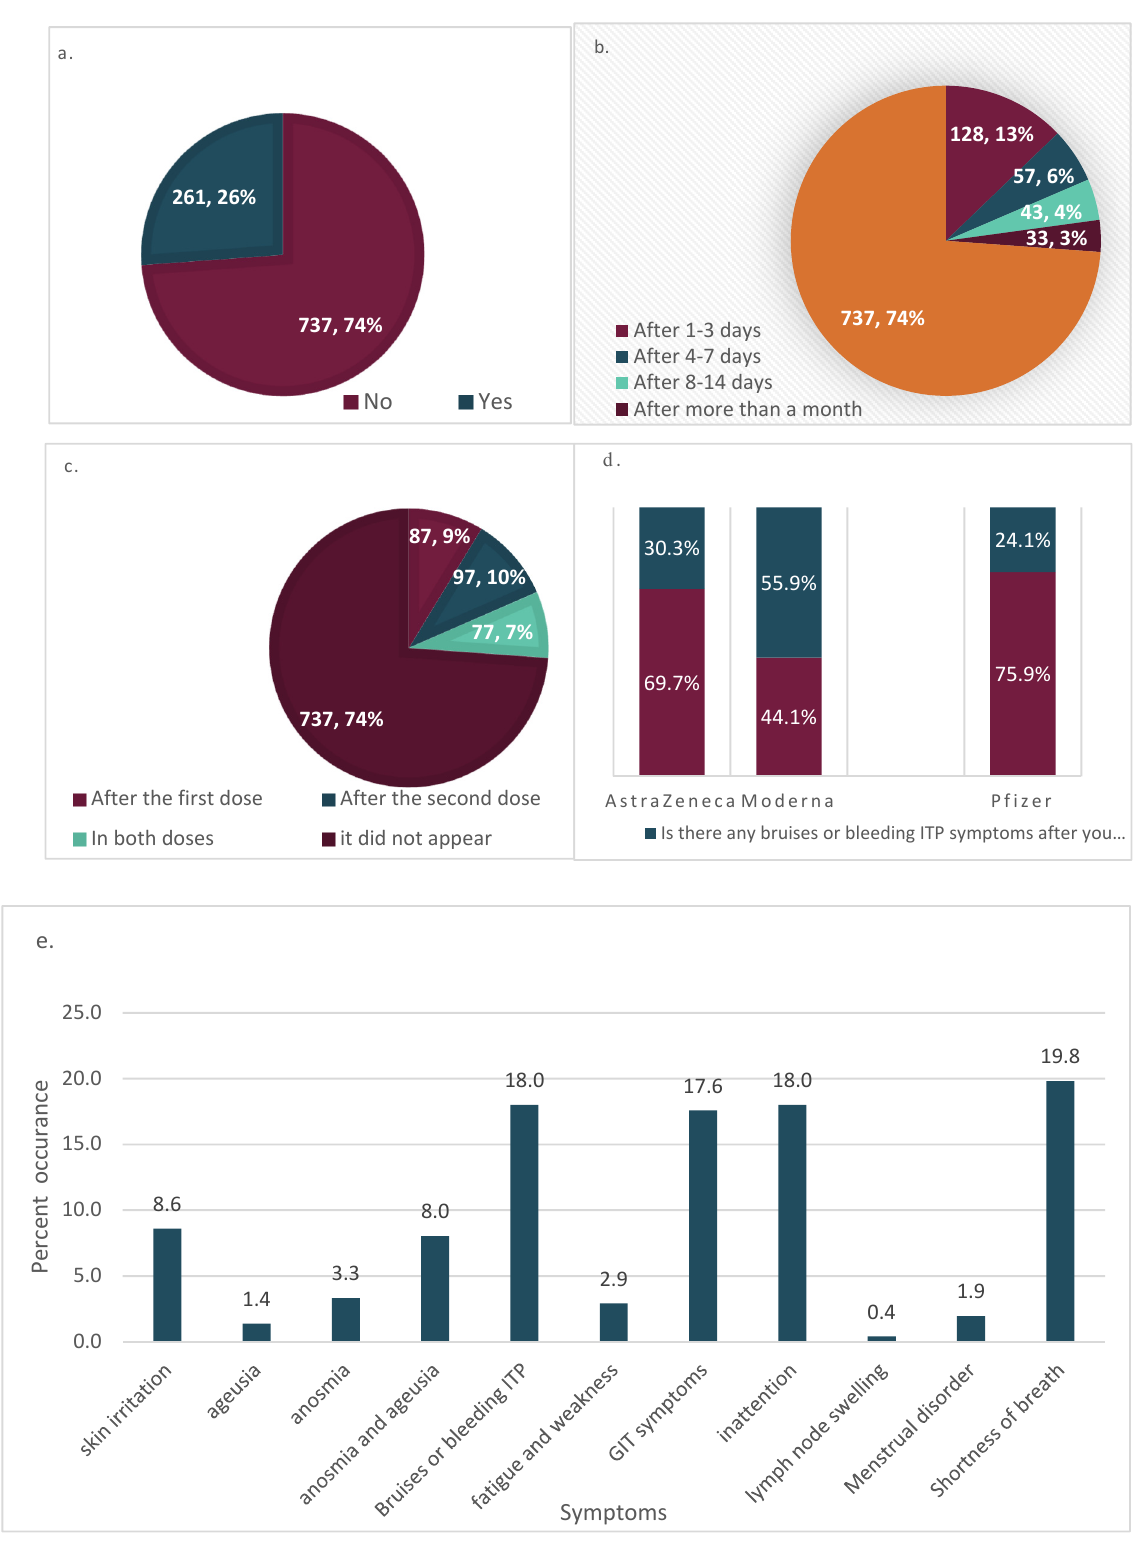
Figure 2. ( a ) Frequency of bruises or bleeding symptoms with high fever post any COVID vaccine administered in Saudi Arabia. ( b ) Overall onset times of ITP symptoms post-COVID vaccine in Saudi Arabia. ( c ) COVID-19 vaccine dose-dependent bruises and bleeding in Saudi Arabia. ( d ) COVID-19 vaccine type-dependent typical ITP symptoms in Saudi Arabia. ( e ) Frequencies of direct ITP and other symptoms related to vaccine interaction.